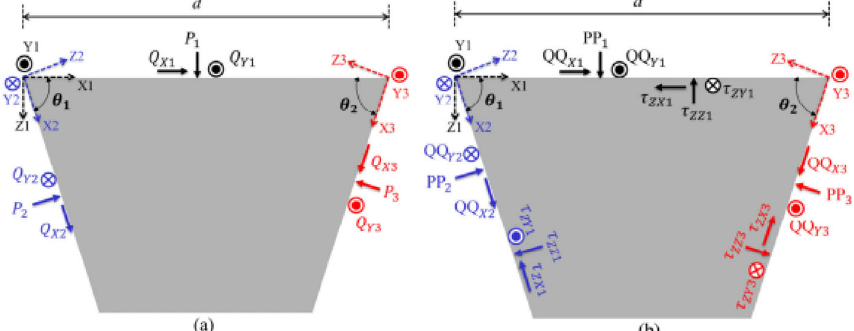
Fig. 67 An elastic wedge with three loaded surfaces [897]. Reproduced with permission from Ref. [897], © The author(s), 2020.